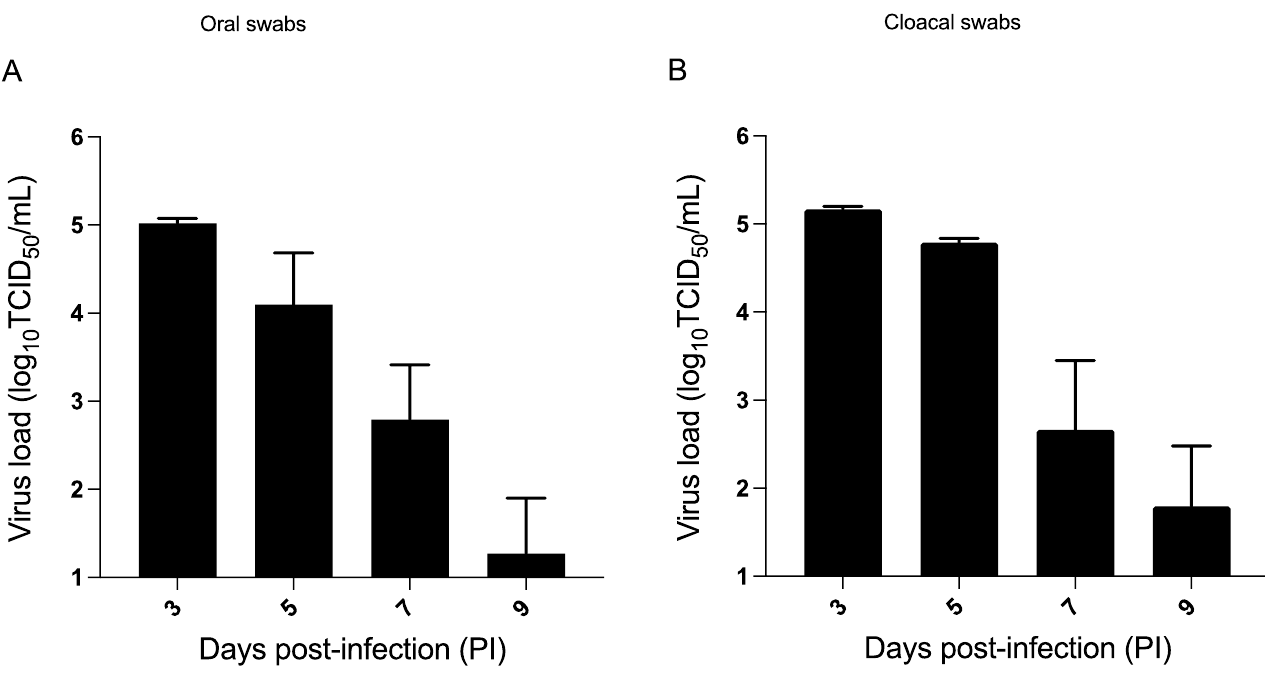
Figure 3. Virus titers in inoculated/seeder group (model A). On day 14 of age, the seeder chickens were infected with H9N2 AIV via direct inoculation route or PBS (unchallenged), respectively ( n = 10). The PBS unchallenged chickens remained negative and did not show any virus shedding throughout the trial. Virus load (log 10 transformed) was assessed in oral ( A ) and cloacal swabs ( B ) based on TCID 50 assay on days 3, -5, -7, and -9 PI.